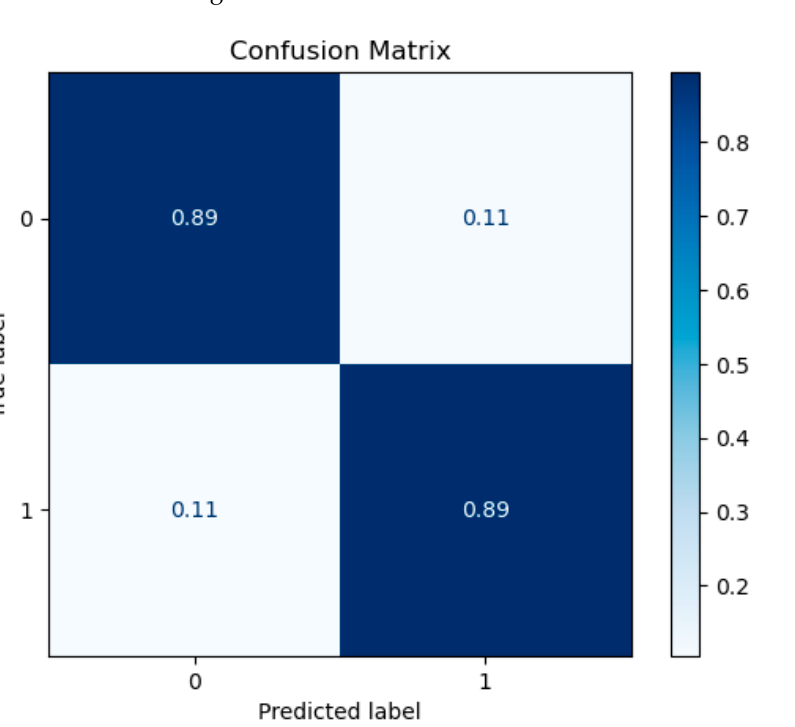
Figure 5. Confusion matrix for SVM model at seven features.